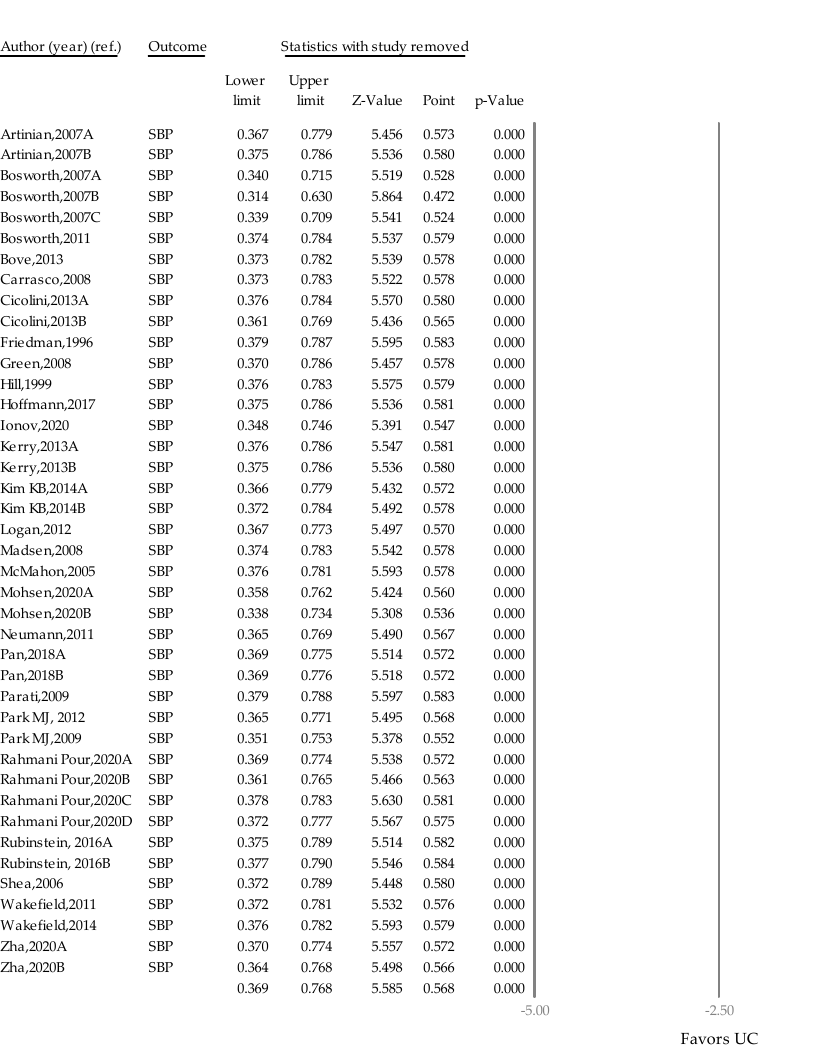
Figure 2. A funnel plot of the standardized mean difference in systolic blood pressure. Note: summary effect size ( ◇ ), Figure A1. Note: point estimate of individual study ( ● ), summary effect size ( ◆ ); SBP, systolic blood pressure; UC, usual summary effect size of imputed studies ( ◆ ), individual study ( ○ ). Figure A1. Note: point estimate of individual study ( • ), summary effect size ( ); SBP, systolic blood pressure; UC, usual care; RBPM, remote blood pressure monitoring. care; RBPM, remote blood pressure Funnel Plot of Standard Error by Std diff in means